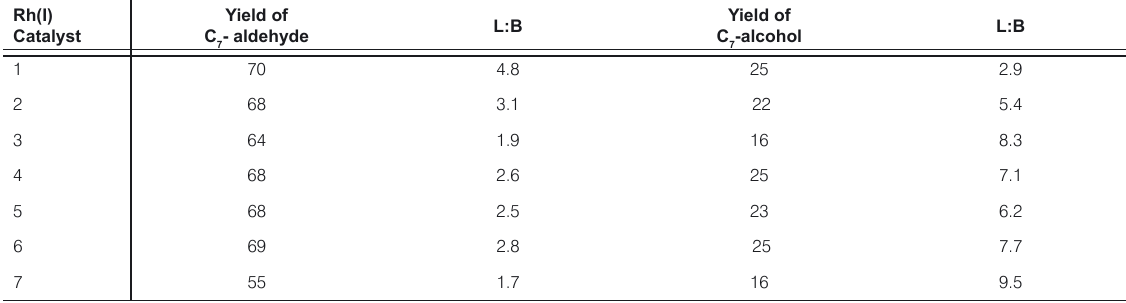
Table 3. Single-Phase Catalytic Hydroformylation of 1-hexene in aqueous Ethanol (1:1). Rh(I) Catalyst